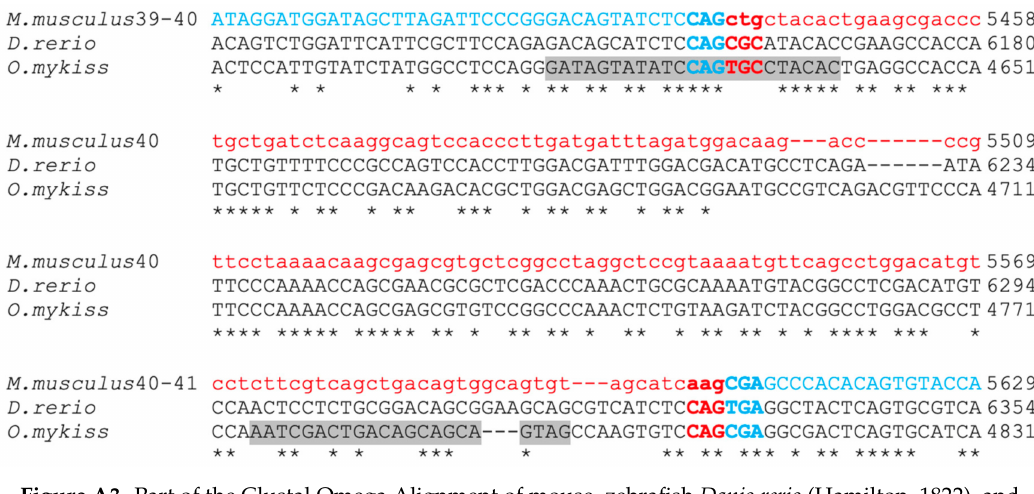
Figure A3. Part of the Clustal Omega Alignment of mouse, zebrafish Danio rerio (Hamilton, 1822), and O. mykiss PIEZO2 CDS (European Bioinformatics Institute, 2018). Shown are exons 39 through 41 with high identity across the species. Exon-exon boundaries are labeled in blue and red. Position of primer pair 1 is shown by grey underlay. Exon 40 of the murine ortholog is alternatively spliced and deleted in non-neural tissues [63]. Sequence and exon-exon borders were provided by [63]. (Accession number D. rerio